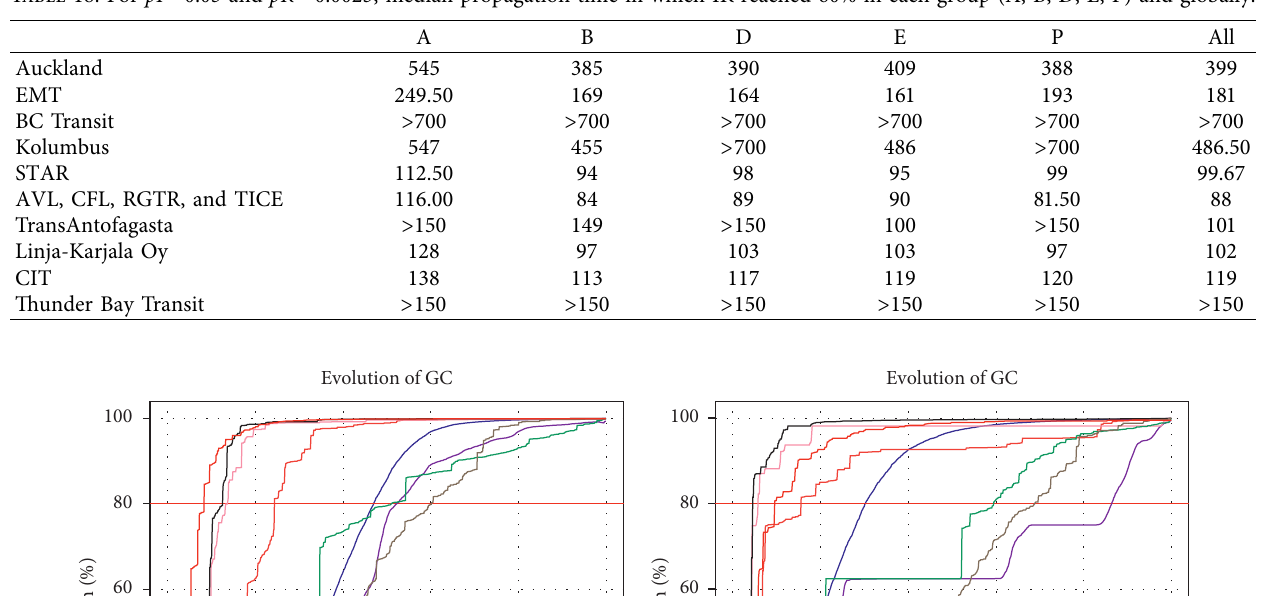
Table 18: For pI � 0.05 and pR � 0.0025, median propagation time in which IR reached 60% in each group (A, B, D, E, P) and